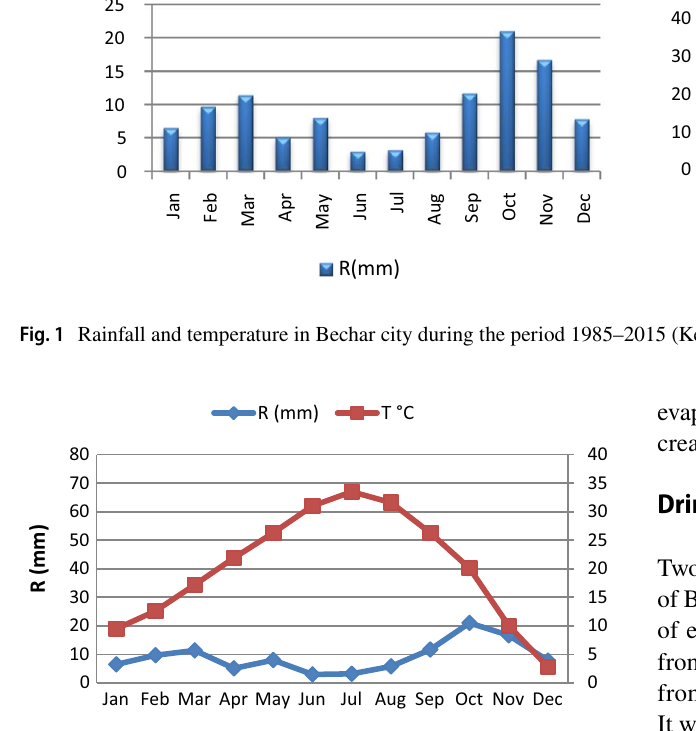
Fig. 2 Ombrothermal diagram of Gaussen of Bechar